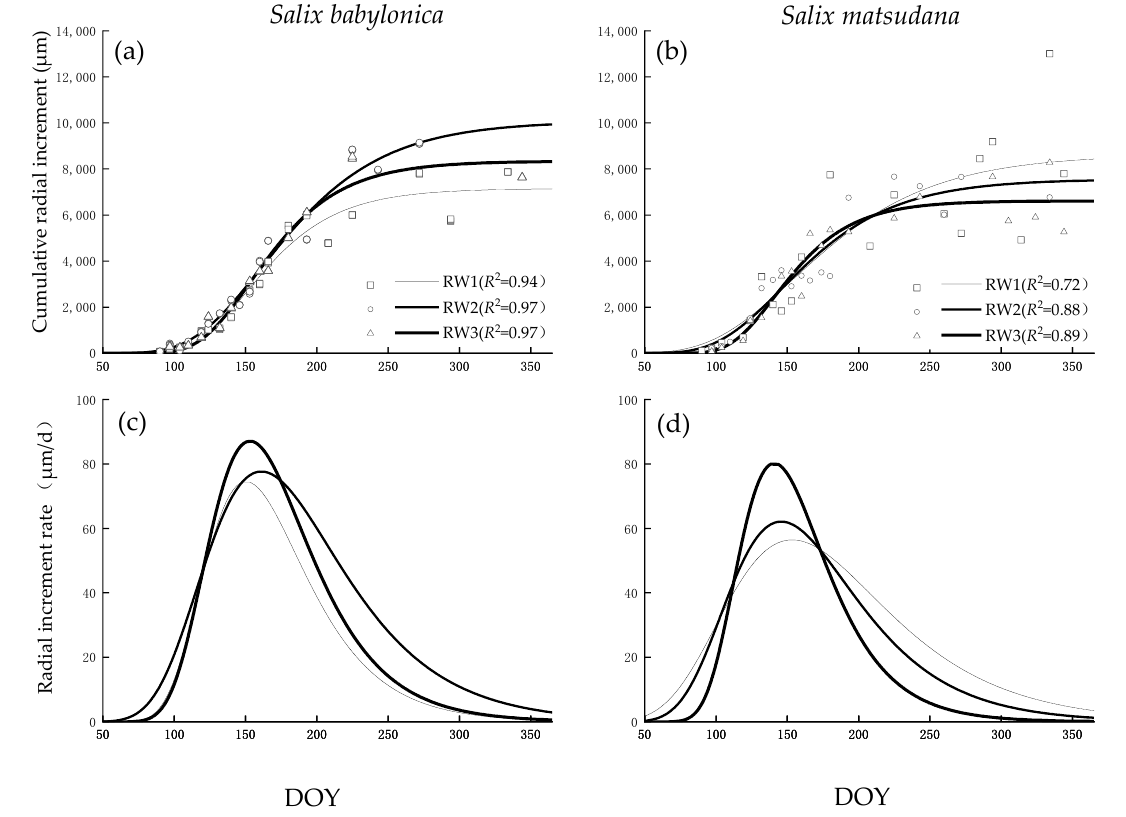
Figure 4. ( a , b ) Intra-annual xylem growth dynamics and ( c , d ) the daily growth rate of Salix babylonica and Salix matsudana . Dots and lines represent the measured value and fitted value by the Gompertz function, respectively.